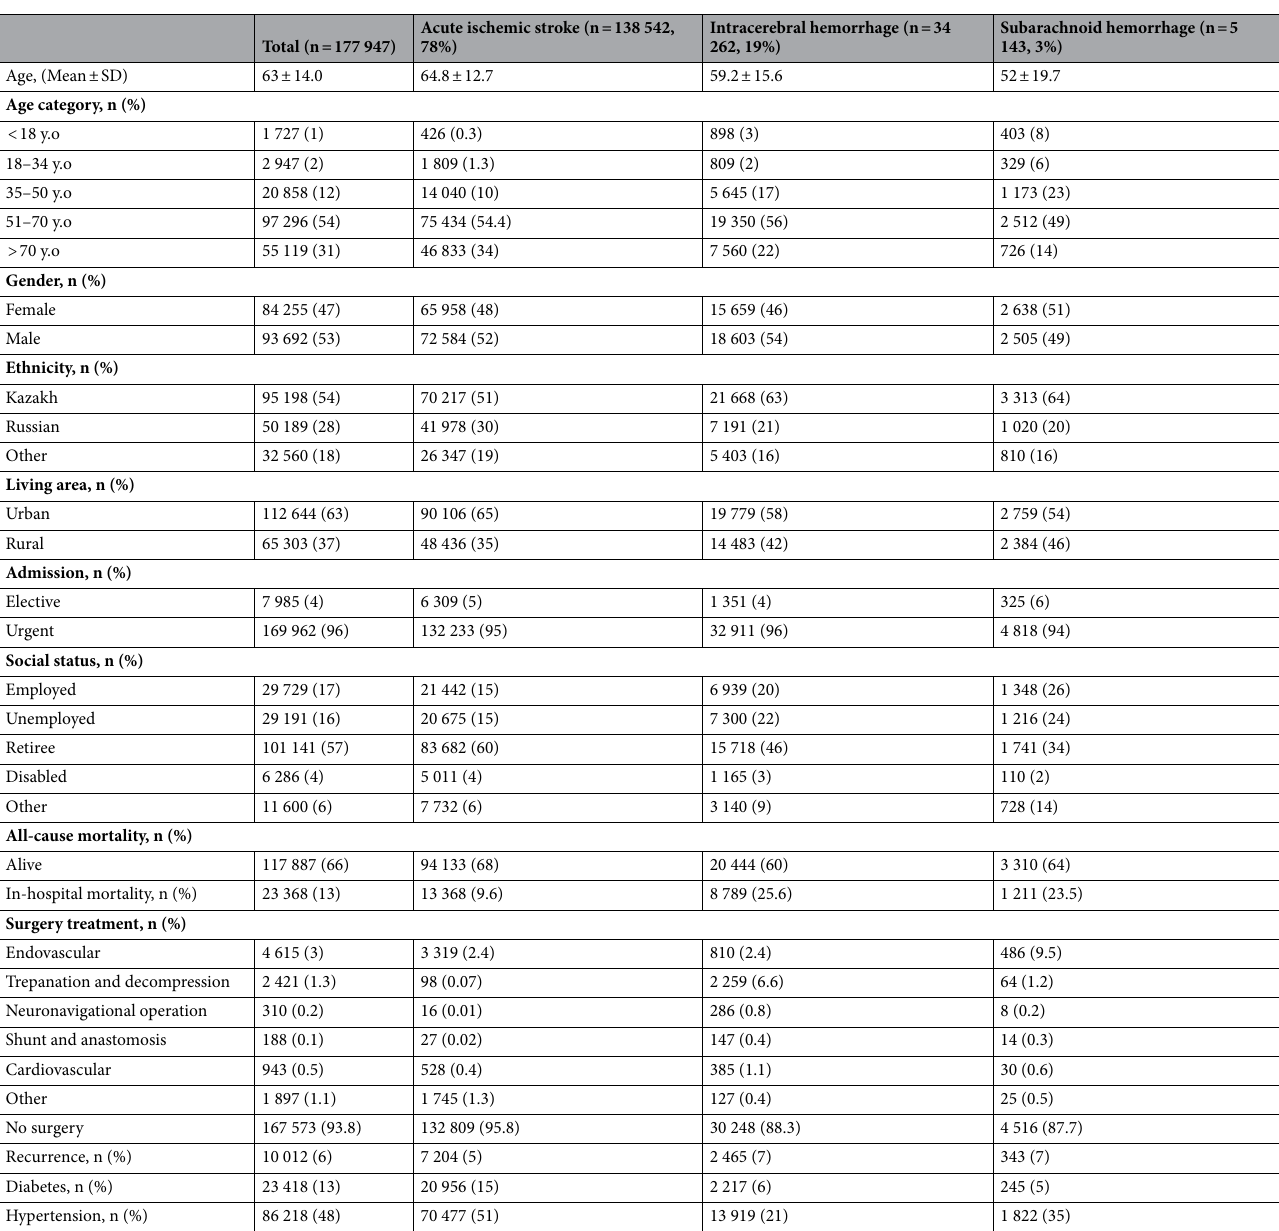
Table 1. Socio-demographic and medical characteristics of patients with different types of stroke for the years